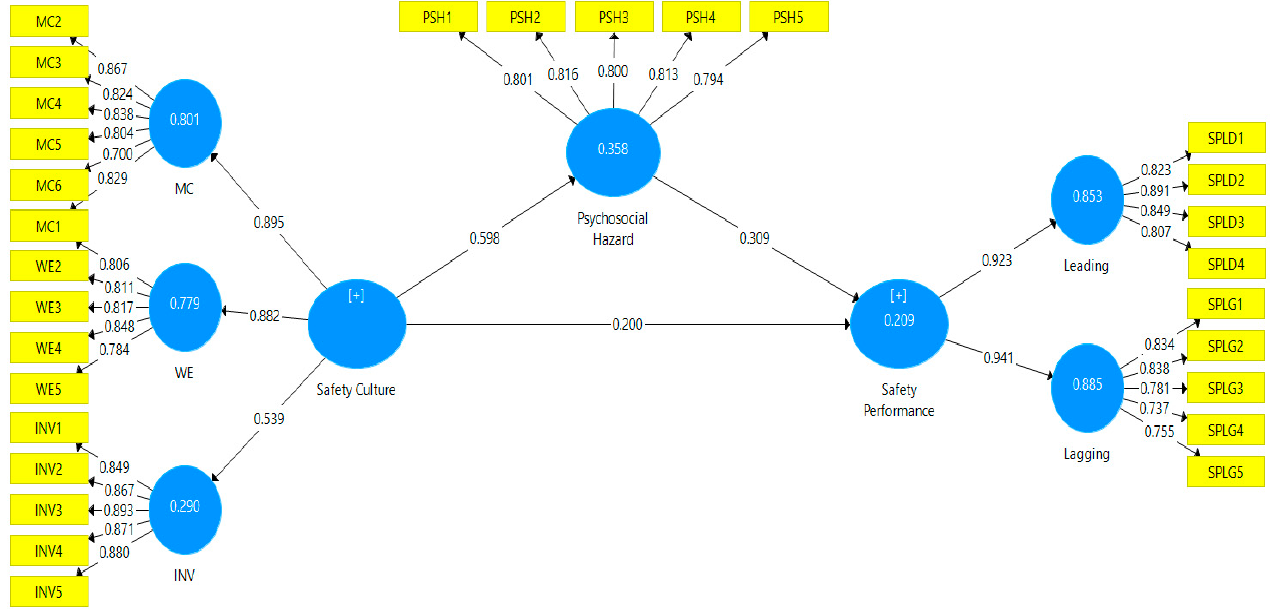
Figure 3. Measurement model outcomes.